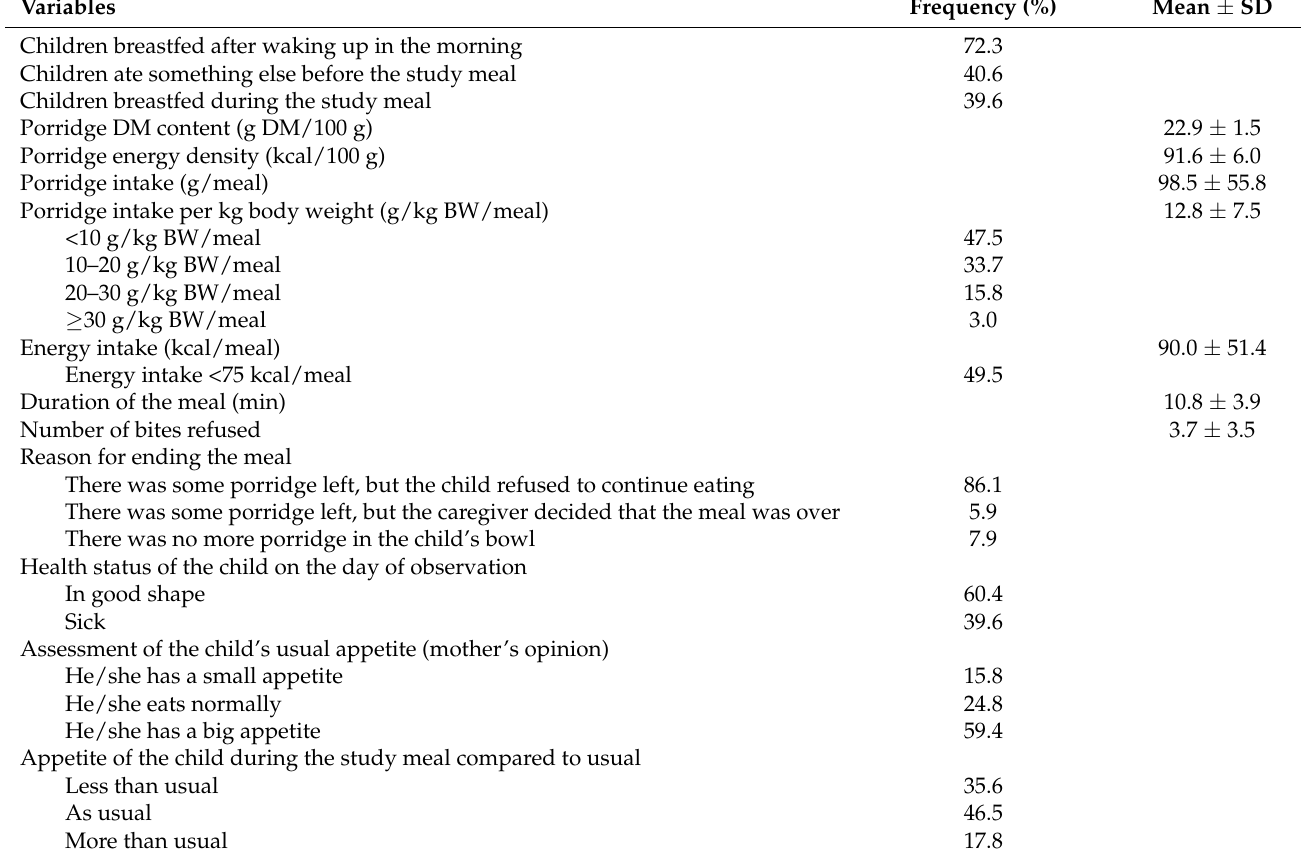
Table 3. Feeding practices before/during the study meal ( n = 101).